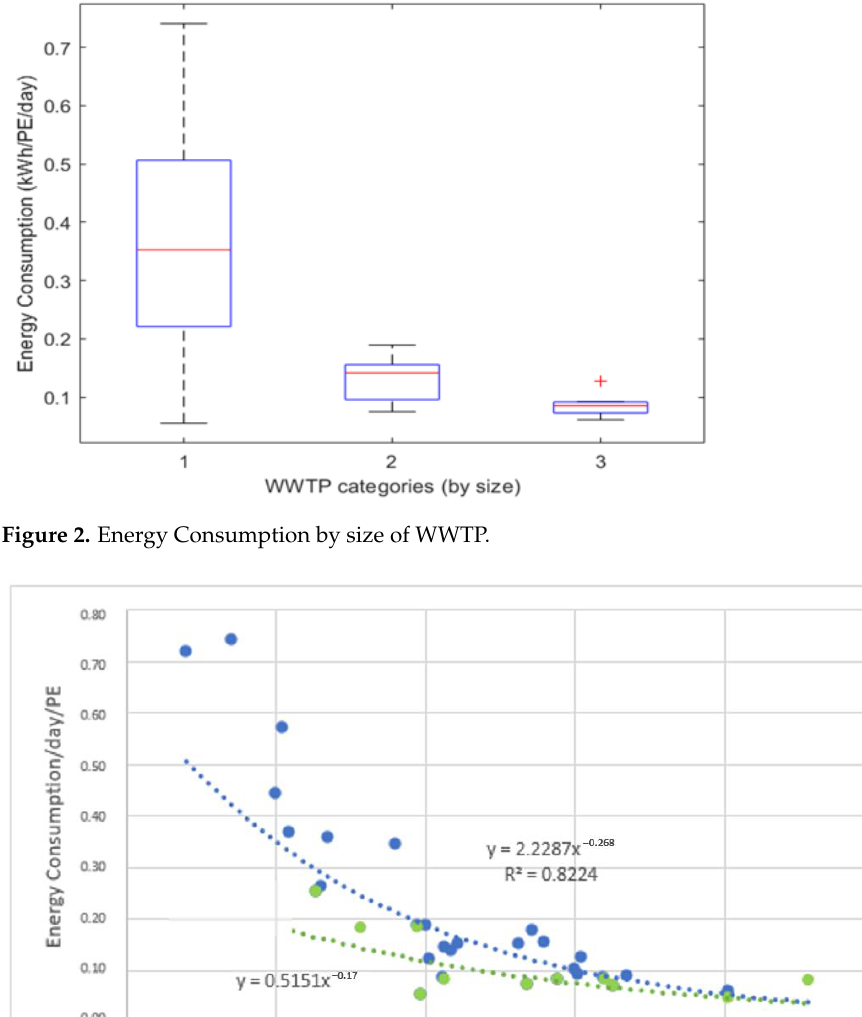
Figure 4. Percentage of Aeration Energy Consumption. The contribution of each treatment stage in the total energy footprint for each WWTP is highlighted in Figures 5 and 6. Based on these data, it is anticipated that the biological treatment (i.e., aeration and secondary treatment) is the primary energy consumption,